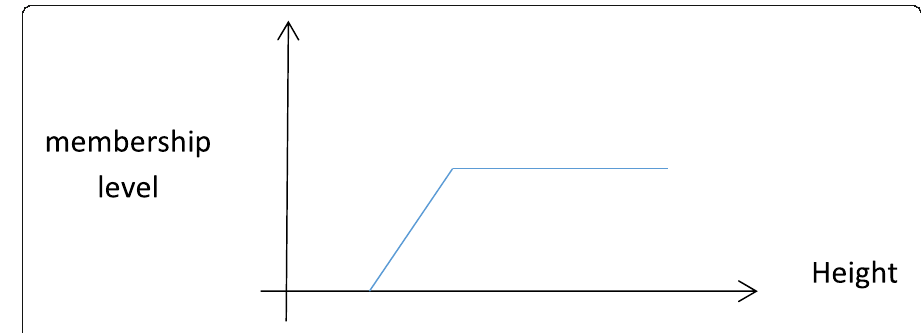
Fig. 9 Membership function of tallness. This Fig considers the expression of the people ’ s height in the fuzzy theory. The degree of tallness for individuals between 150 and 180 cm